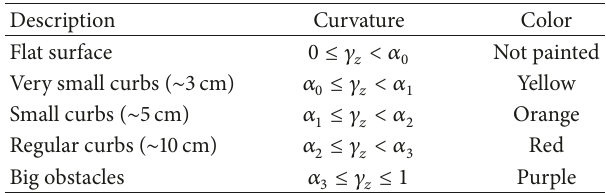
Table 2: Curb curvature